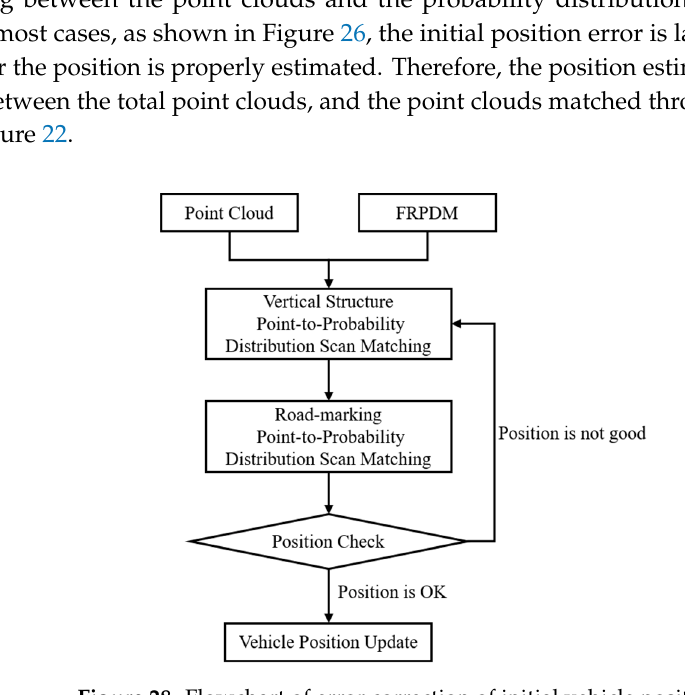
Figure 28. Flowchart of error correction of initial vehicle position.